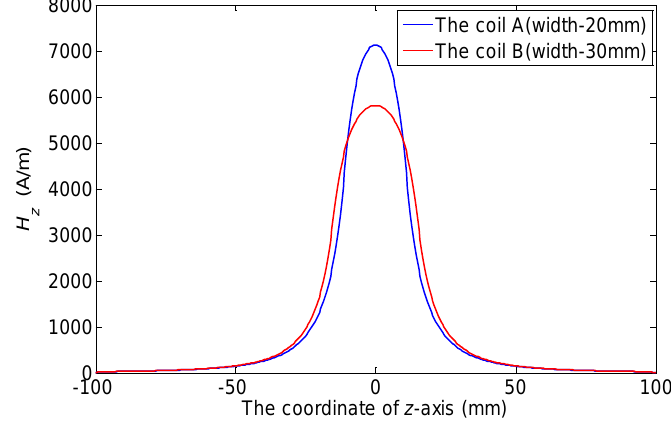
Figure 6. The axial magnetic field strength ( H two different